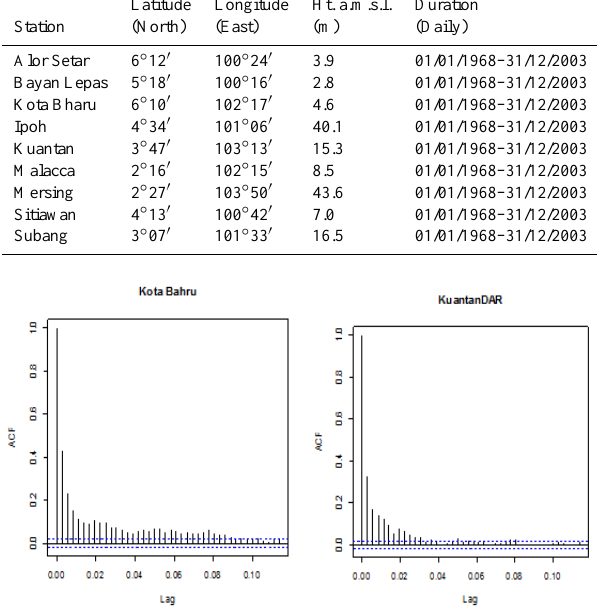
Fig. 2. Autocorrelation function of the data sets of Kota Bahru and Kuantan